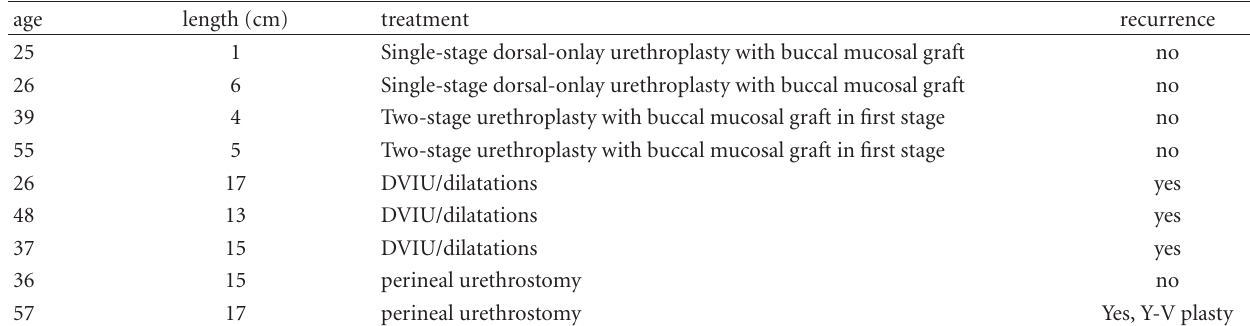
Table 1: Characteristics of 9 adult urethral stricture patients with childhood hypospadias